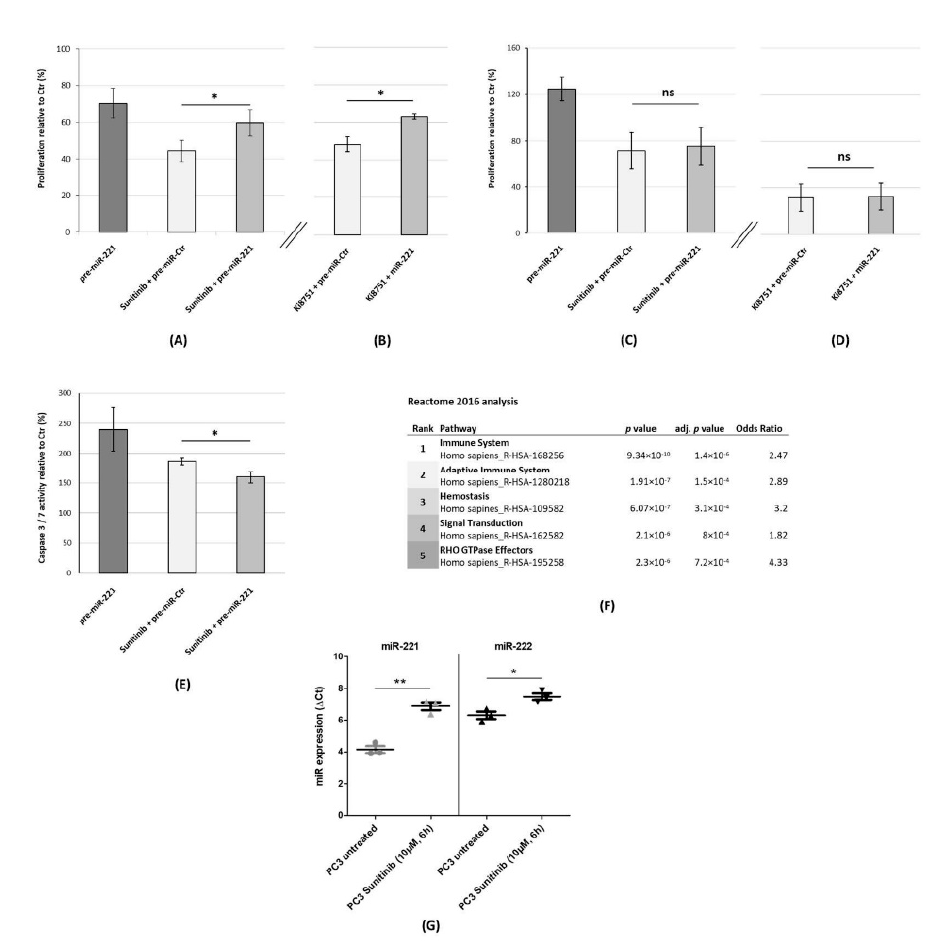
Figure 3. Re-expression of miR-221 as part of an escape mechanism from VEGFR2 inhibition in PC3 cells. Figure 3. Re ‐ expression of miR ‐ 221 as part of an escape mechanism from VEGFR2 inhibition in PC3 ( A ) Elevation of cellular miR-221 levels (by pre-miR-221 transfection) counteracts the e ff ect of Sunitinib cells. ( A ) Elevation of cellular miR ‐ 221 levels (by pre ‐ miR ‐ 221 transfection) counteracts the effect of administration. ( B ) Restoration of cellular miR-221 expression is associated with a higher proportion Sunitinib administration. ( B ) Restoration of cellular miR ‐ 221 expression is associated with a higher of viable cells after Ki8751 treatment. ( A , B ) PC3 cells were transiently transfected with pre-miR-221 or proportion of viable cells after Ki8751 treatment. ( A, B ) PC3 cells were transiently transfected with pre-miR-Ctr. Sunitinib (10 µ M) or Ki8751 (10 µ M) were administered 24 h p. t. MTS assays were performed pre ‐ miR ‐ 221 or pre ‐ miR ‐ Ctr. Sunitinib (10 μ M) or Ki8751 (10 μ M) were administered 24 h p. t. MTS 72 h p. t. ( C , D ). Pre-miR-221 transfection did not significantly alter the response towards Sunitinib ( C ) and assays were performed 72 h p. t. ( C, D ). Pre ‐ miR ‐ 221 transfection did not significantly alter the Ki8751 ( D ) in castration-sensitive LNCaP cells. TKI (both 10 µ M) were administered 24h p. t. The MTS response towards Sunitinib ( C ) and Ki8751 ( D ) in castration ‐ sensitive LNCaP cells. TKI (both 10 μ M) assays were performed 72 h p. t. ( E ) miR-221 overexpression significantly lowered apoptosis induction were administered 24h p. t. The MTS assays were performed 72 h p. t. ( E ) miR ‐ 221 overexpression after Sunitinib treatment (10 µ M; 12 h), as indicated by relative Caspase 3 / 7 activity. ( F ) Reactome significantly lowered apoptosis induction after Sunitinib treatment (10 μ M; 12 h), as indicated by 2016 analysis of publicly available microarray data revealed an interferon-related / immune-mediated relative Caspase 3/7 activity. ( F ) Reactome 2016 analysis of publicly available microarray data revealed signature in PC3 cells after Sunitinib exposure (10 µ M, 6 h). ( G ) Significant upregulation of miR-221 an interferon ‐ related / immune ‐ mediated signature in PC3 cells after Sunitinib exposure (10 μ M, 6 h). ( G ) and miR-222 expression after Sunitinib treatment (10 µ M, 6 h) in PC3 cells. ( A–G ) ns: not significant. Significant upregulation of miR ‐ 221 and miR ‐ 222 expression after Sunitinib treatment (10 μ M, 6 h) in *: p < 0.05. **: p < PC3 cells. ( A–G ) ns: not significant. *: p < 0.05. **: p < 0.01.